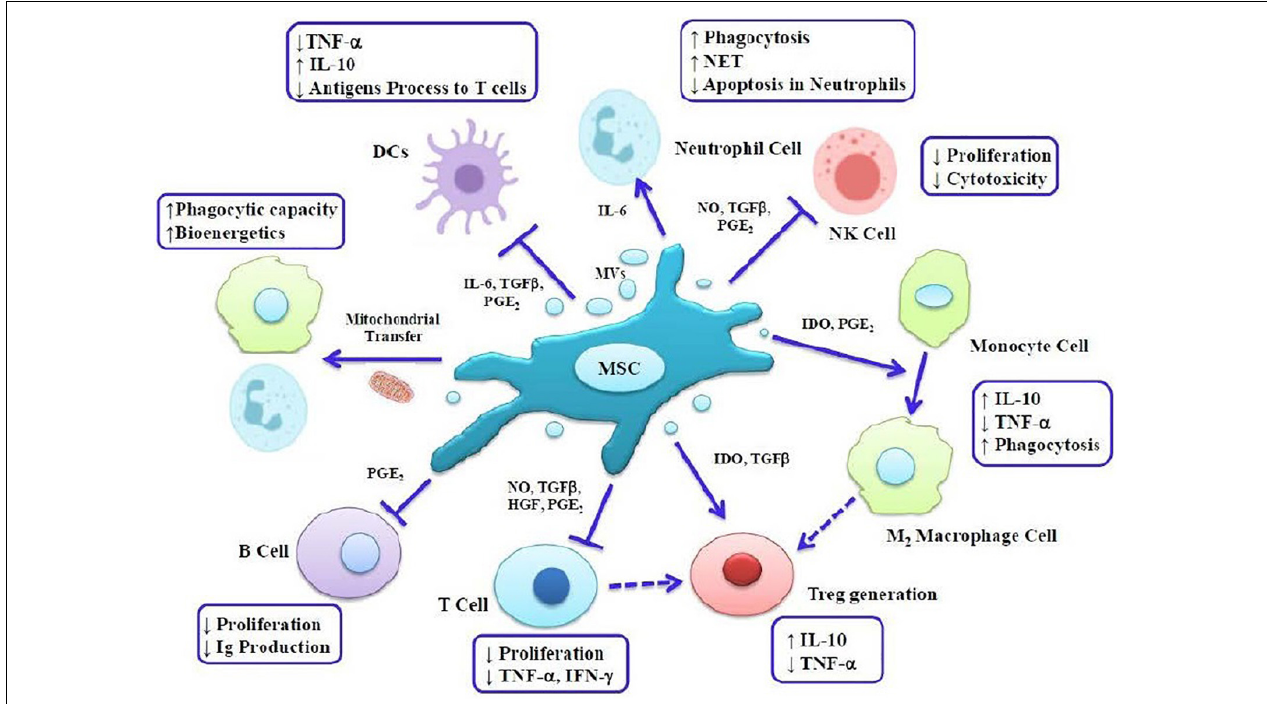
FIGURE 2 | The antibacterial effects of MSC can be indirectly mediated by increasing phagocytic activity of macrophages and neutrophils. These cells can also induce immunomodulatory effects by modulating immune responses and regulating cytokine homeostasis. MVs, microvesicles; DC, dendritic cell; NKC, natural killer cell; NET, neutrophil extracellular trap; IFN, interferon; TNF, tumor necrosis factor; NO, nitric oxide; PGE2, prostaglandin E2; TGF, transforming growth factor; IDO, indoleamine 2,3 dioxygenase; Treg, T regulatory cell; Ig,